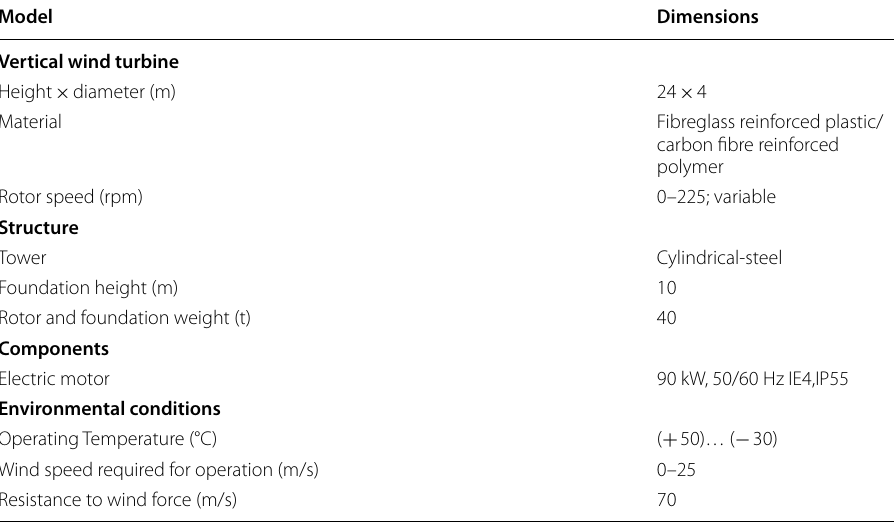
Table 1 Technical data sheet of the large vertical wind turbine adapted for a container ship (Craft et al. 2012; Demadi et al. 2010)